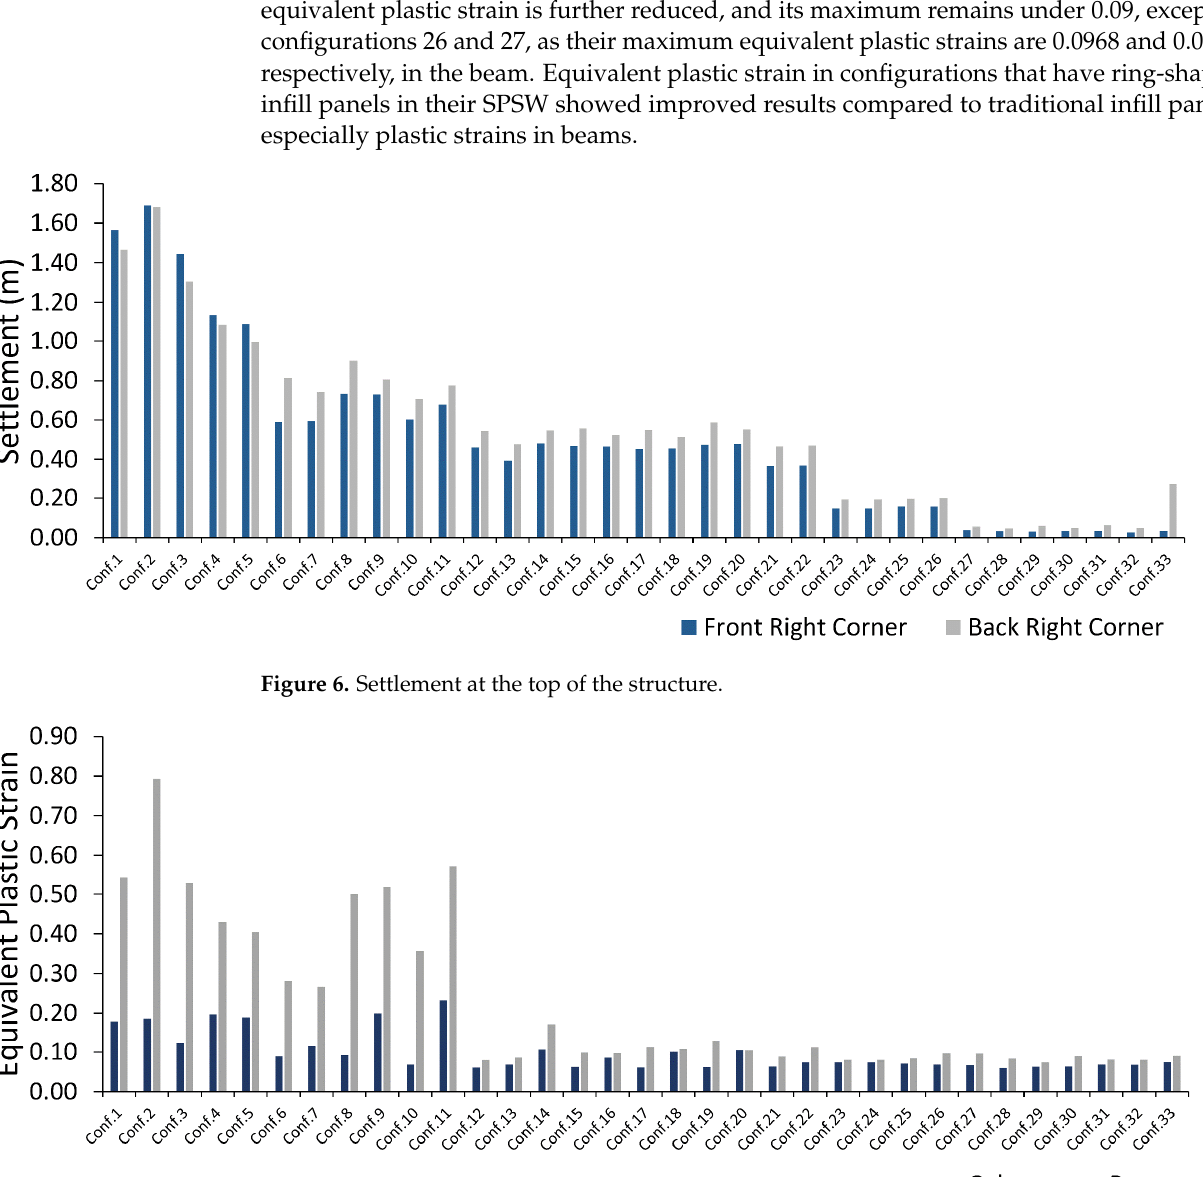
Figure 7. Maximum Equivalent Plastic Strain.